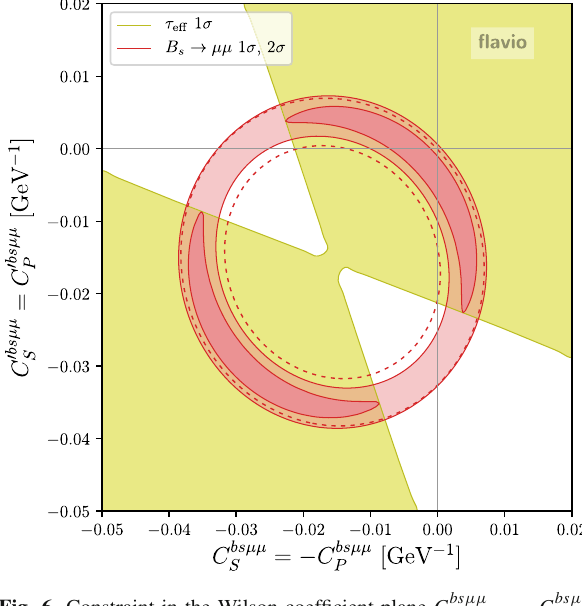
Fig. 6 Constraint in the Wilson coefficient plane C bs (cid:6) bs μμ = C (cid:6) bs μμ vs. C . The red band shows at 1 σ and 2 σ the constraints S P μμ , C (cid:6) bs μμ ) = ( 0 , 0 ) . The dashed lines show the for ( C bs 10 10